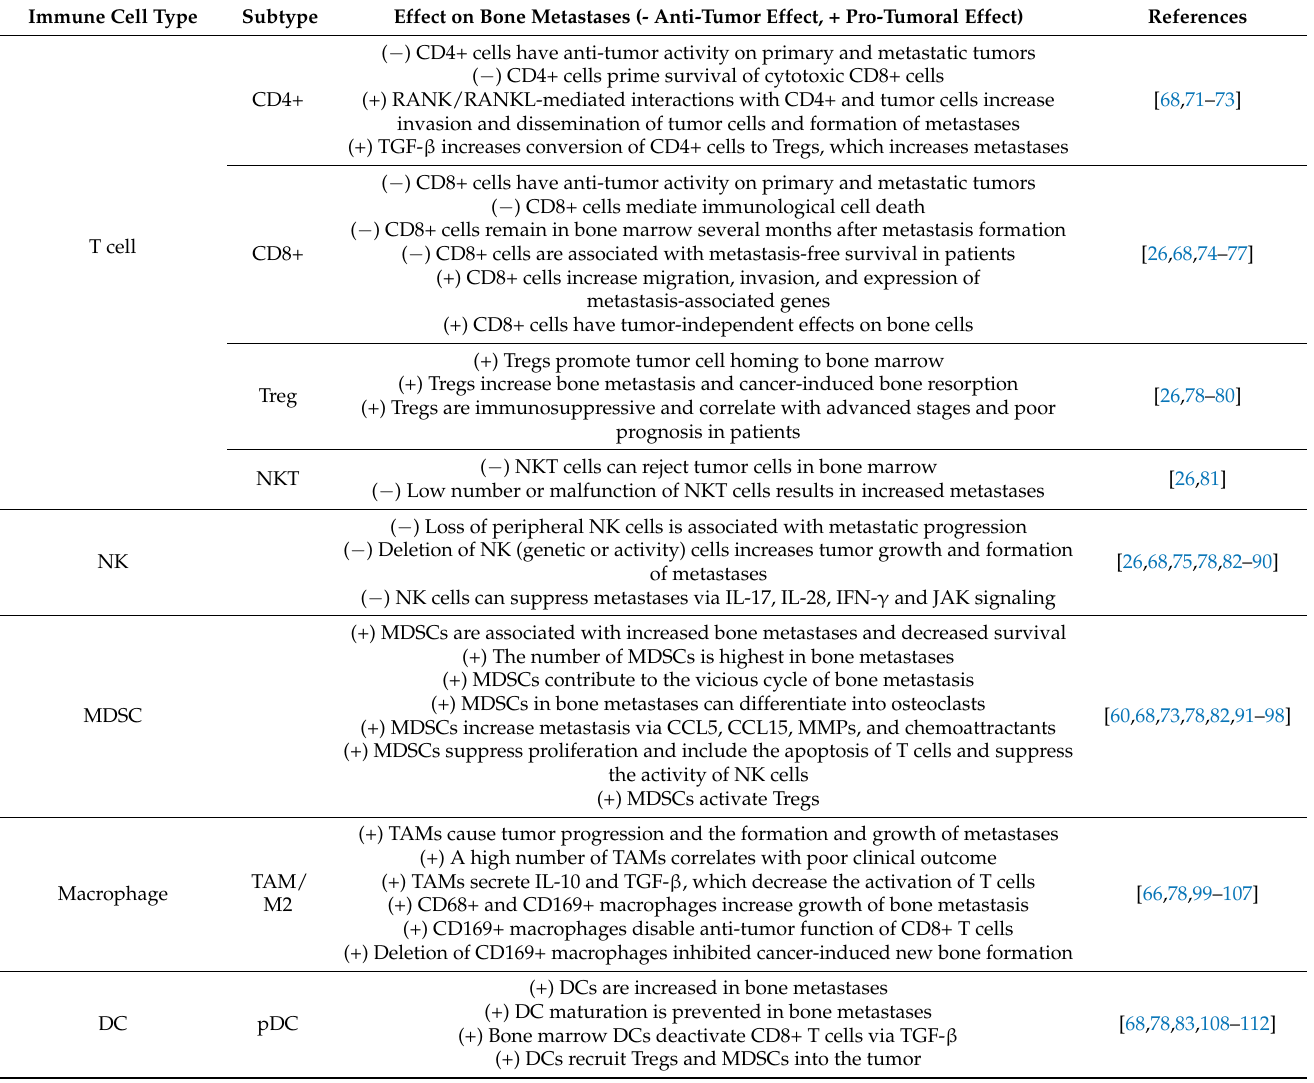
Table 1. Summary of the current understanding of major anti- ( − ) and pro-tumoral (+) effects of immune cells on bone metastases, as per the published in vitro and in vivo studies and clinical findings. More detailed information is found in Sections